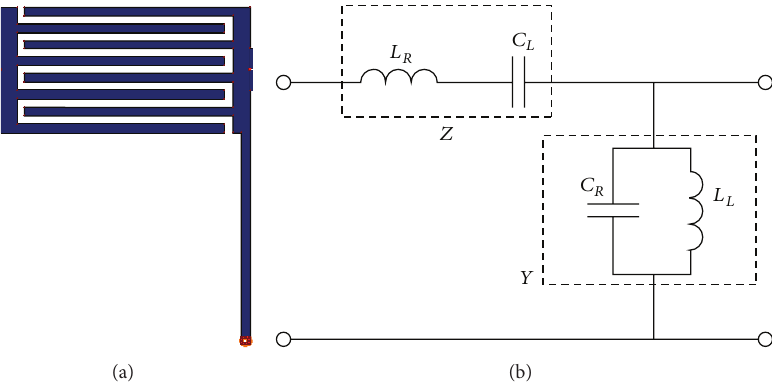
Figure 1: (a) Infinitesimal element of MTM (b) and its equivalent circuit consisting of inherent series inductor 𝐿 𝑅 , shunt capacitor 𝐶 𝑅 , artificially inserted series capacitor 𝐶 𝐿 , and shunt inductor 𝐿 𝐿 .